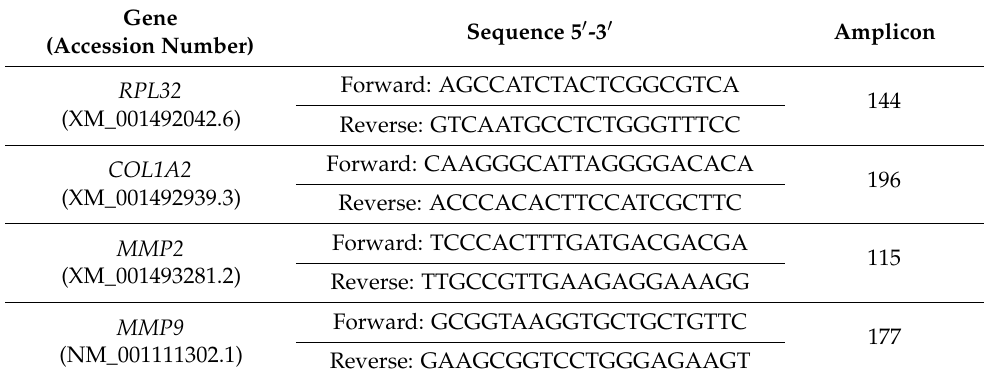
Table 1. List of primers utilized in quantitative real-time polymerase chain reaction